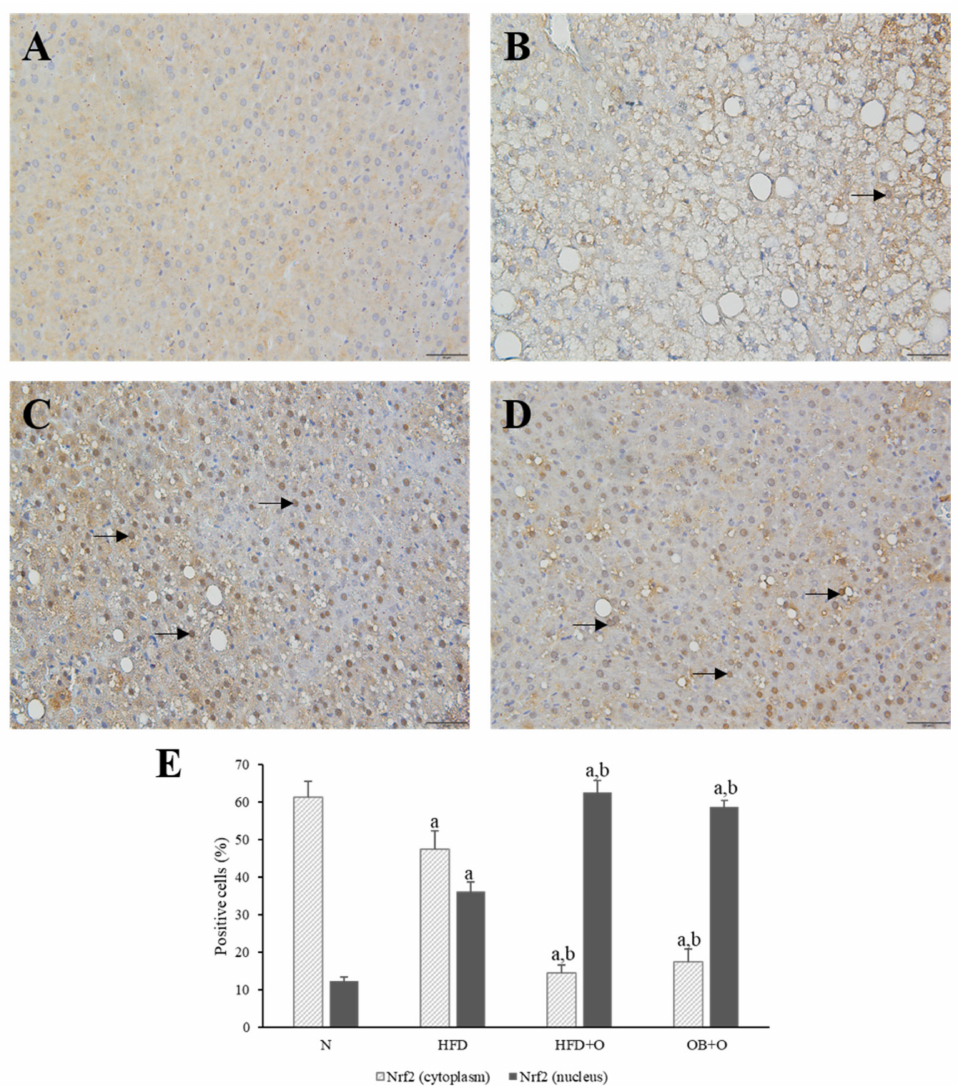
Figure 5. ( A – E ). Immunohistochemical staining of Nrf2 expression in liver sections. N, normal control; HFD, high-fat diet; HFD + O, high-fat diet + orlistat 10 mg/kg/day (protective model); OB + O, obese + orlistat 10 mg/kg/day (therapeutic model); Nrf2, nuclear factor erythroid 2-related factor 2. ( A ) N group shows accumulation of Nrf2 in the cytoplasm than in the nuclei. ( B ) More Nrf2 was concentrated in the nuclei of the HFD group than in the N group. ( C , D ) This concentration morphology was more apparent after orlistat administration in the HFD + O and OB + O groups. Magnification, × 400. Arrows indicate nucleus-positive cells. ( E ) Quantification of Nrf2-positive cells (%). Data are expressed as mean ± SEM, n = 6/group. One-way ANOVA, followed by Tukey post-hoc test. a p < 0.05 vs. N group, b p < 0.05 vs. HFD